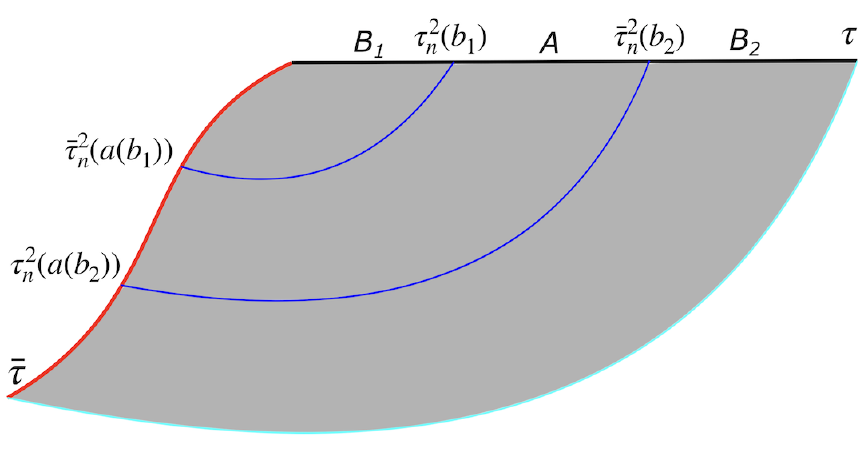
Figure 17: Schematic for the islands proposal -II for the entanglement negativity of a a single interval- A in